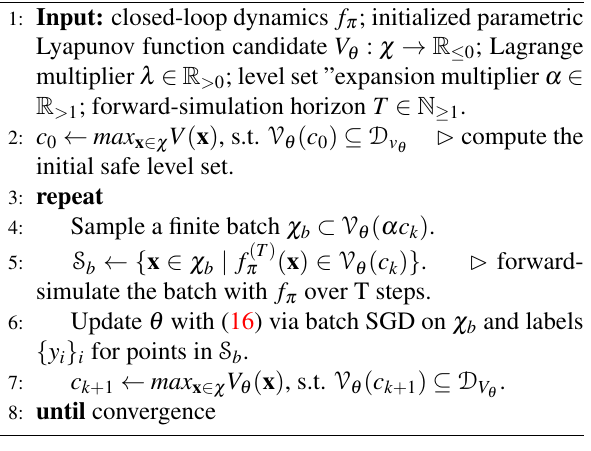
Algorithm 1 ROA Classifier Training Richards et al. (2018)